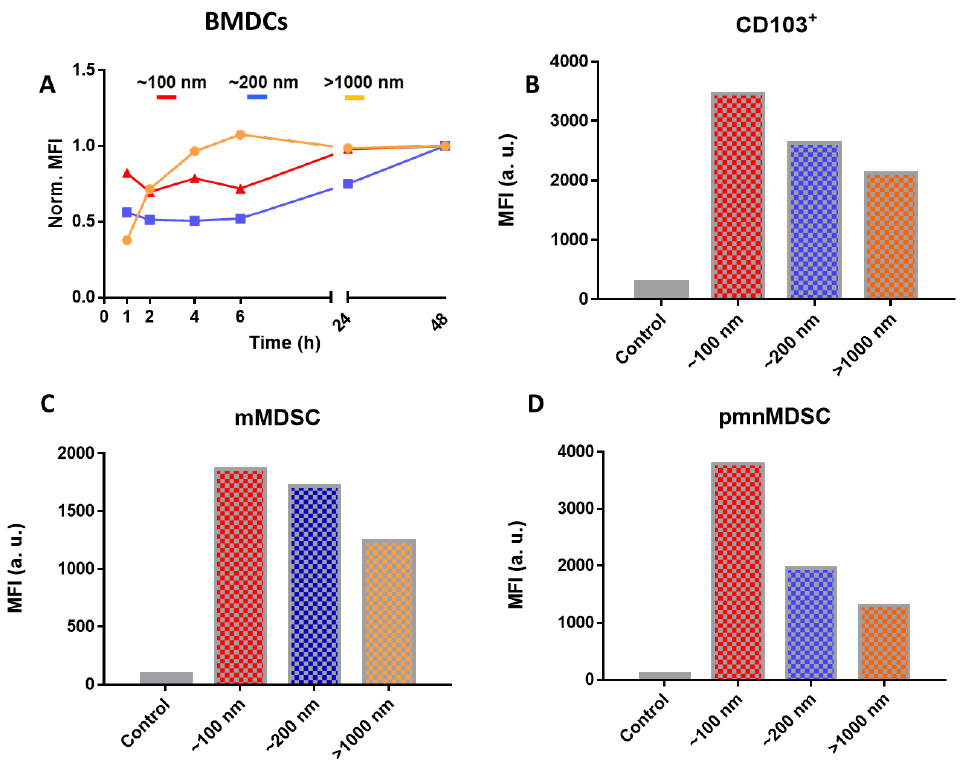
Figure 3. ( A ) Intracellular mean fluorescence intensity (MFI) values obtained for >1000 nm (orange), ~200 nm (blue), and ~100 nm (red) PLGA particles incubated with bone marrow-derived dendritic cells (BMDCs) for different time periods, and ( B ) correlation between the particle size and intracellular MFI after 2 h of incubation with CD103 + dendritic cells, ( C ) monocytic myeloid-derived suppressor cells (MDSCs), and ( D ) polymorphonuclear MDSCs isolated from mouse. Data were obtained using flow cytometry.